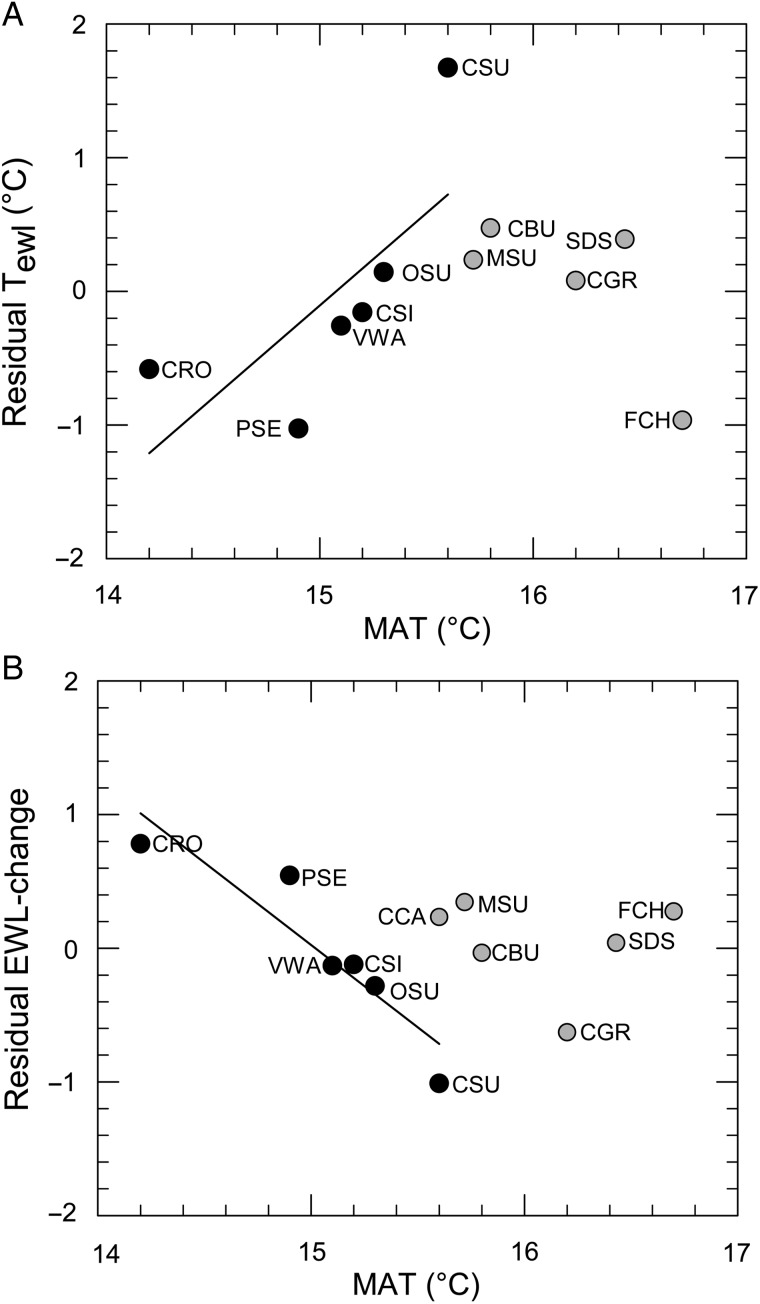
The relationship between mean annual air temperature (MAT; in degrees Celsius) experienced across each species' range, and mass-corrected residuals of upper inflection air temperature for evaporative water loss (Tewl; A) and EWL-change (ratio of EWL at Tair = 38°C to Tair at 30°C; B). Black circles represent Fynbos endemics and grey circles represent non-endemics. Trend lines represent significant relationships (P < 0.05; see main text for details on interaction effects). Each species' data point is labelled with a three-letter acronym, as in Fig. 1.